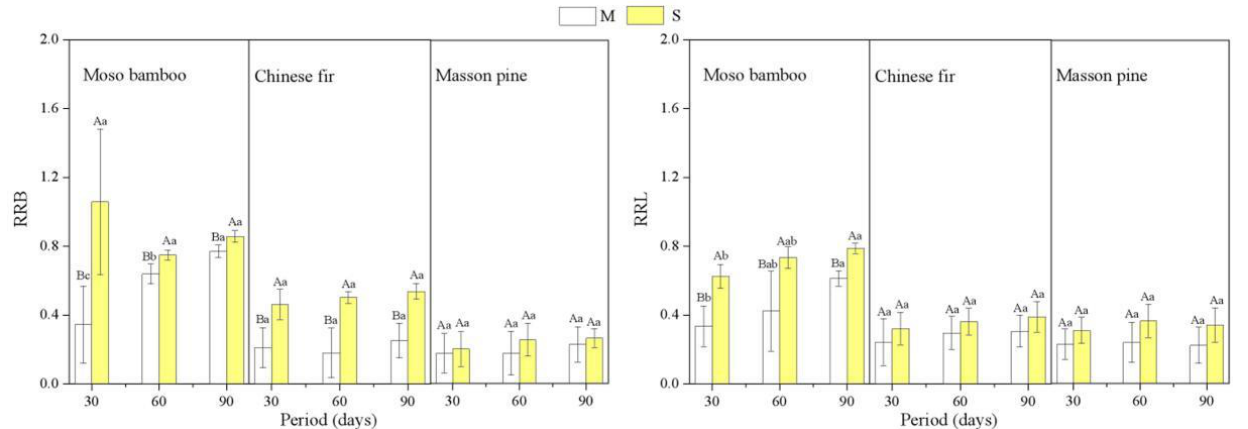
Figure 4. Response ratios of biomass (RRB) and root length (RRL) for the three species to different drought treatments. The capital letters denote significant differences among treatments ( p < 0.05), and the lowercase letters denote significant differences among periods ( p < 0.05).